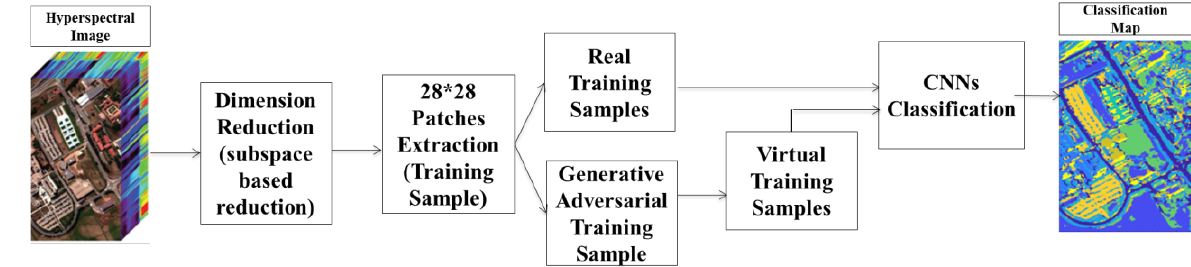
Figure 1. General flow of the proposed framework for hyperspectral image